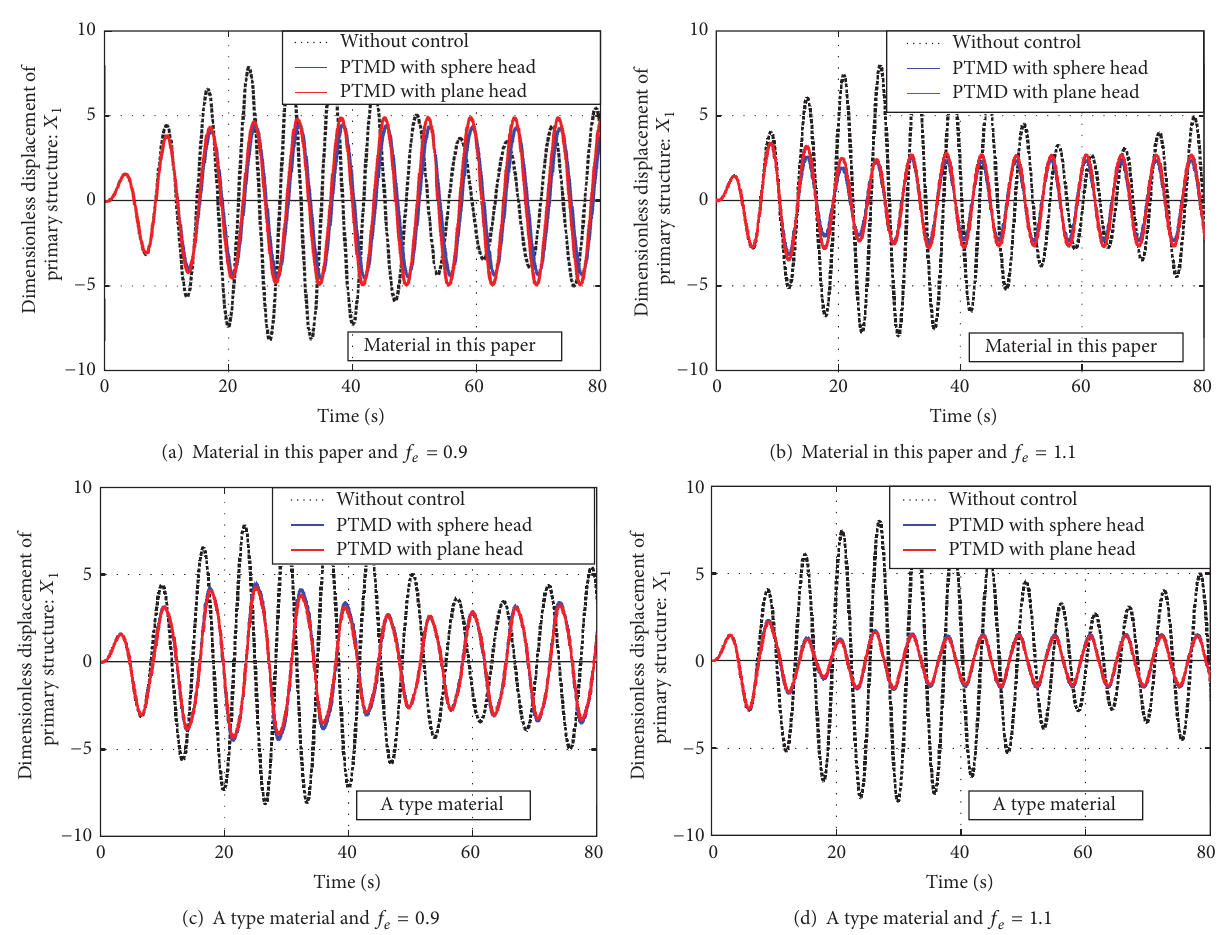
Figure 8: Control performance of PTMD with different contact